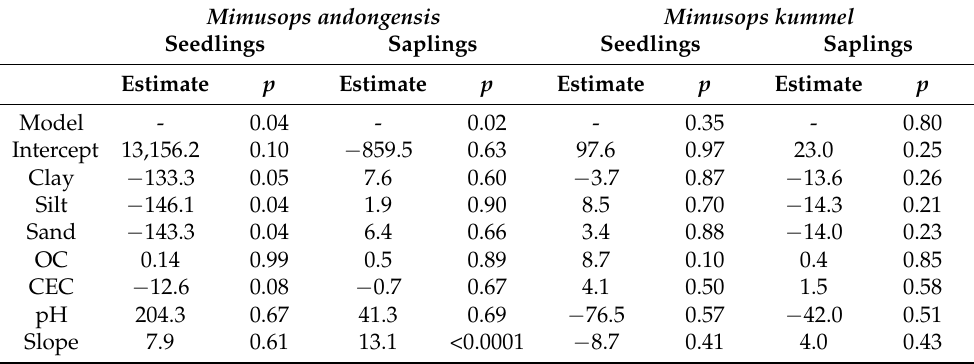
Table 5. Multiple regression coefficients between slope, soil characteristics and regeneration